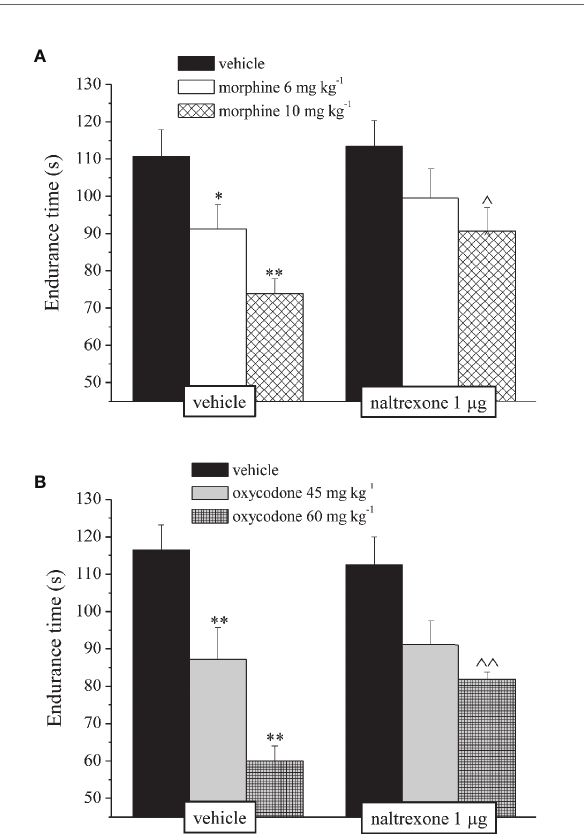
FIGURE 2 | Effect of intranasal administration of naltrexone on morphine and oxycodone induced amnesia in the mouse. Memory impairment was evaluated by the Passive avoidance test. Naltrexone 1 m g was intranasally administered 30 min before the intraperitoneal injection of (A) morphine (6 and 10 mg kg − 1 ) or (B) oxycodone (45 and 60 mg kg − 1 ). Behavioral measurements were performed 30 min after opioid treatment. Control animals were treated with vehicles. Each value represents the mean of 10 mice per group, performed in two different experimental sets. *P < 0.05 and **P < 0.01 vs vehicle-treated animals; ^P < 0.05 vs morphine or oxycodone-treated animals.